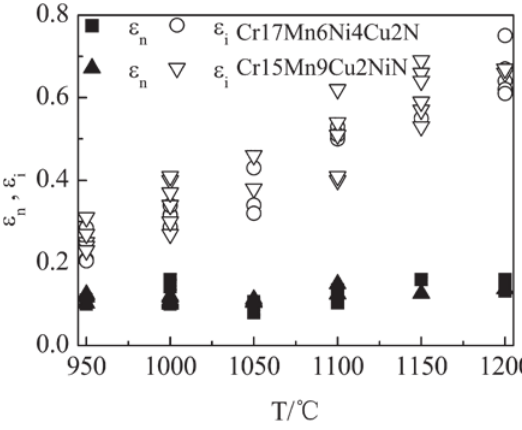
Fig. 6: Geometrical instability strains and necking